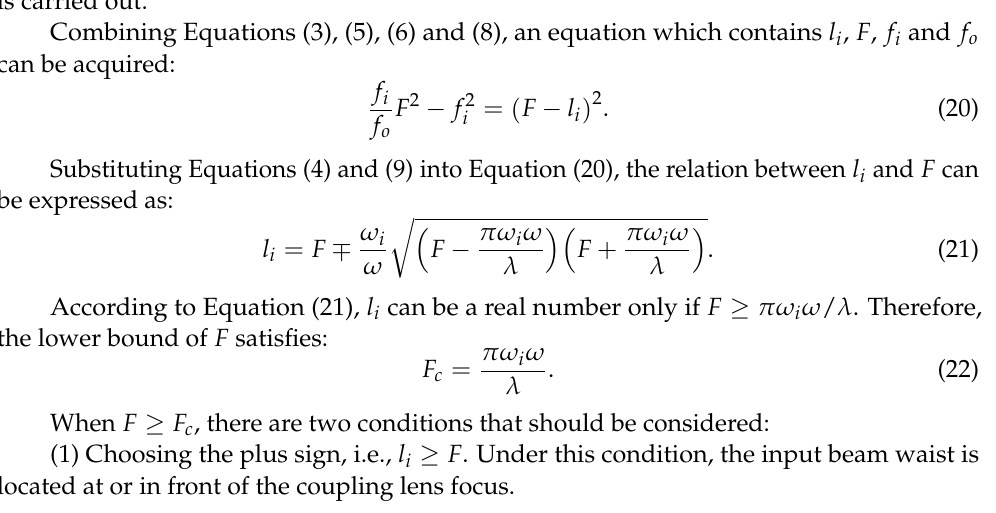
Figure 5. The coupling efficiency as a function of F with different l i when l 0 = l ( a ), the mode field of rod fiber ( b ), the mode field of coupled beam when F increased from 47 mm to 117 mm with l i = 900 mm ( c – j ).